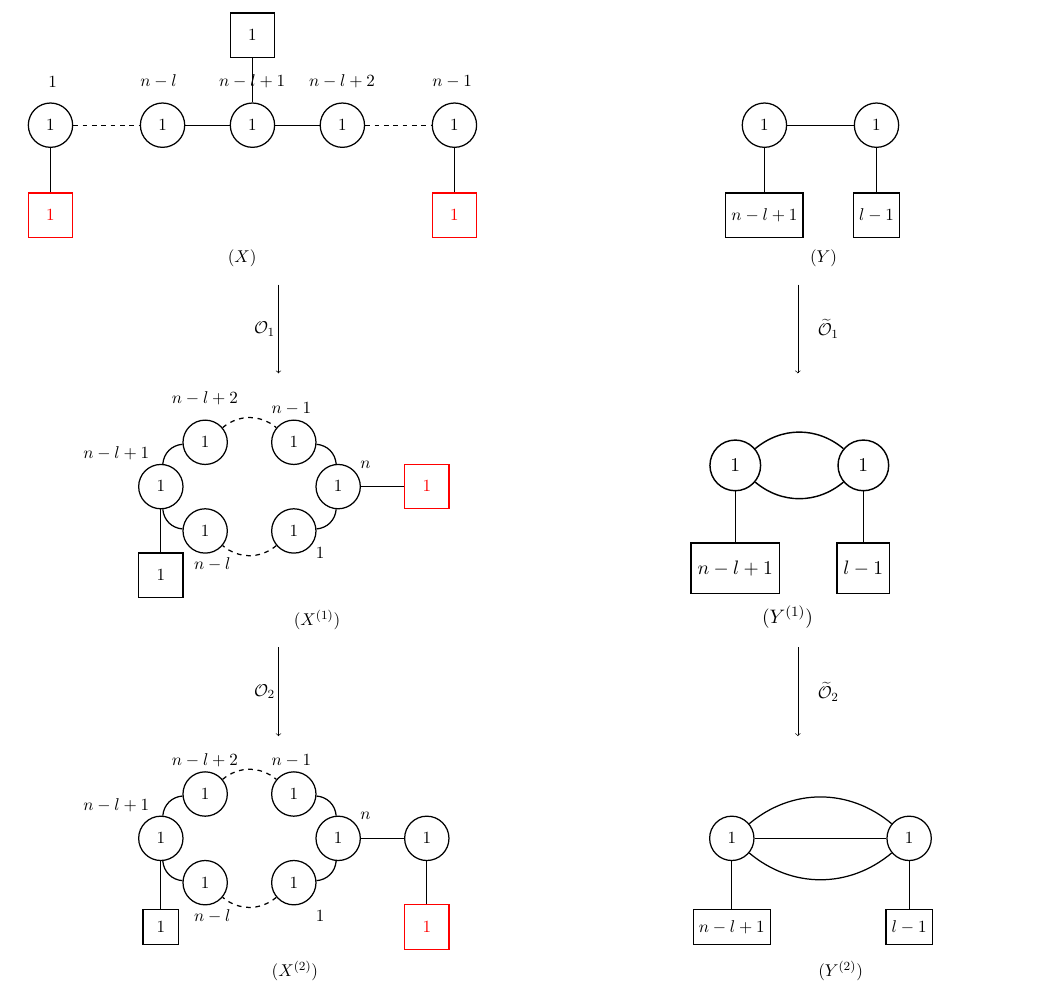
Figure 45 . The quiver ( X 0 ) and its mirror dual ( Y 0 ) in figure 17 (for p = 3 ) is generated by a sequence of elementary S -type operations on different nodes. In each step, the flavor node(s) on which the S -type operation acts is shown in red. The intermediate step involves a flavored b A quiver and its